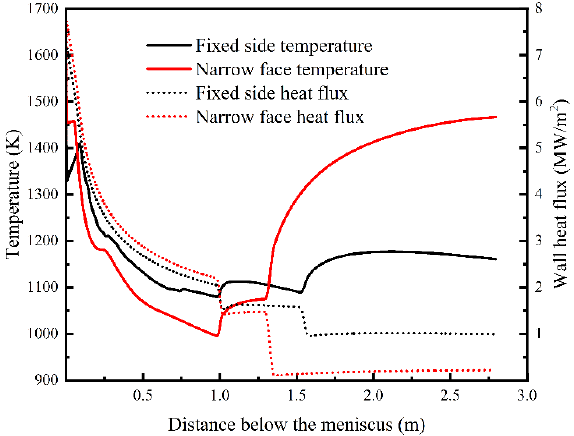
Figure 13. Heat flux profiles and strand surface temperatures as a function of distance from the meniscus. The centerlines of the narrow and wide faces were monitored.